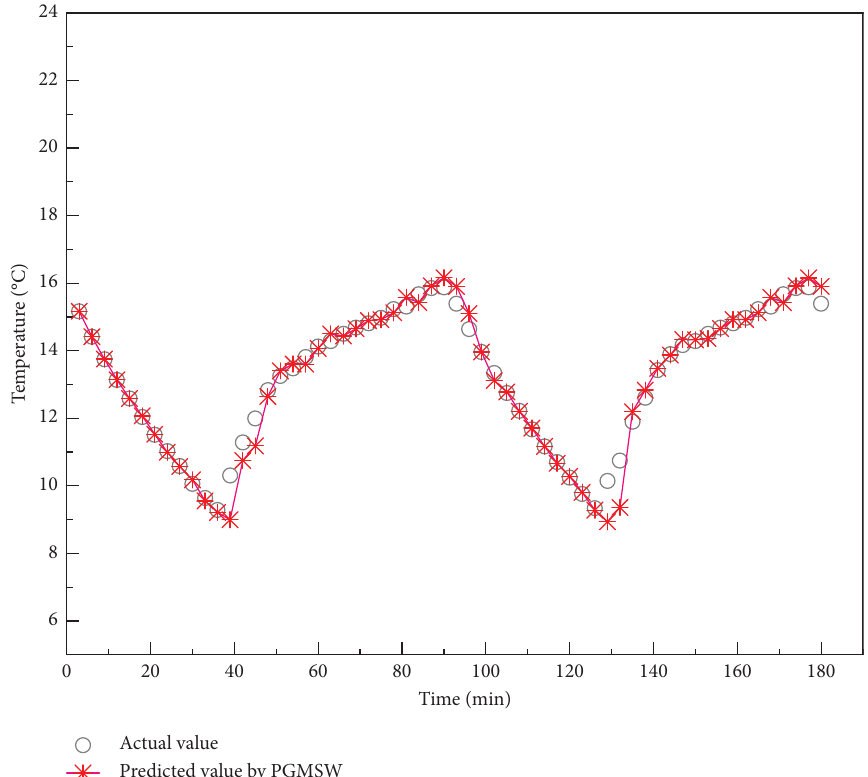
Figure 5: Fitting of values predicted by PGMSW model to telemetry data (window size �